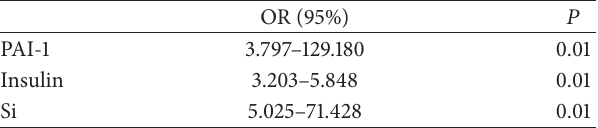
Table 3: Independent factors related to T2D patients for develop- ment of ATIS in binary logistic regression analysis.